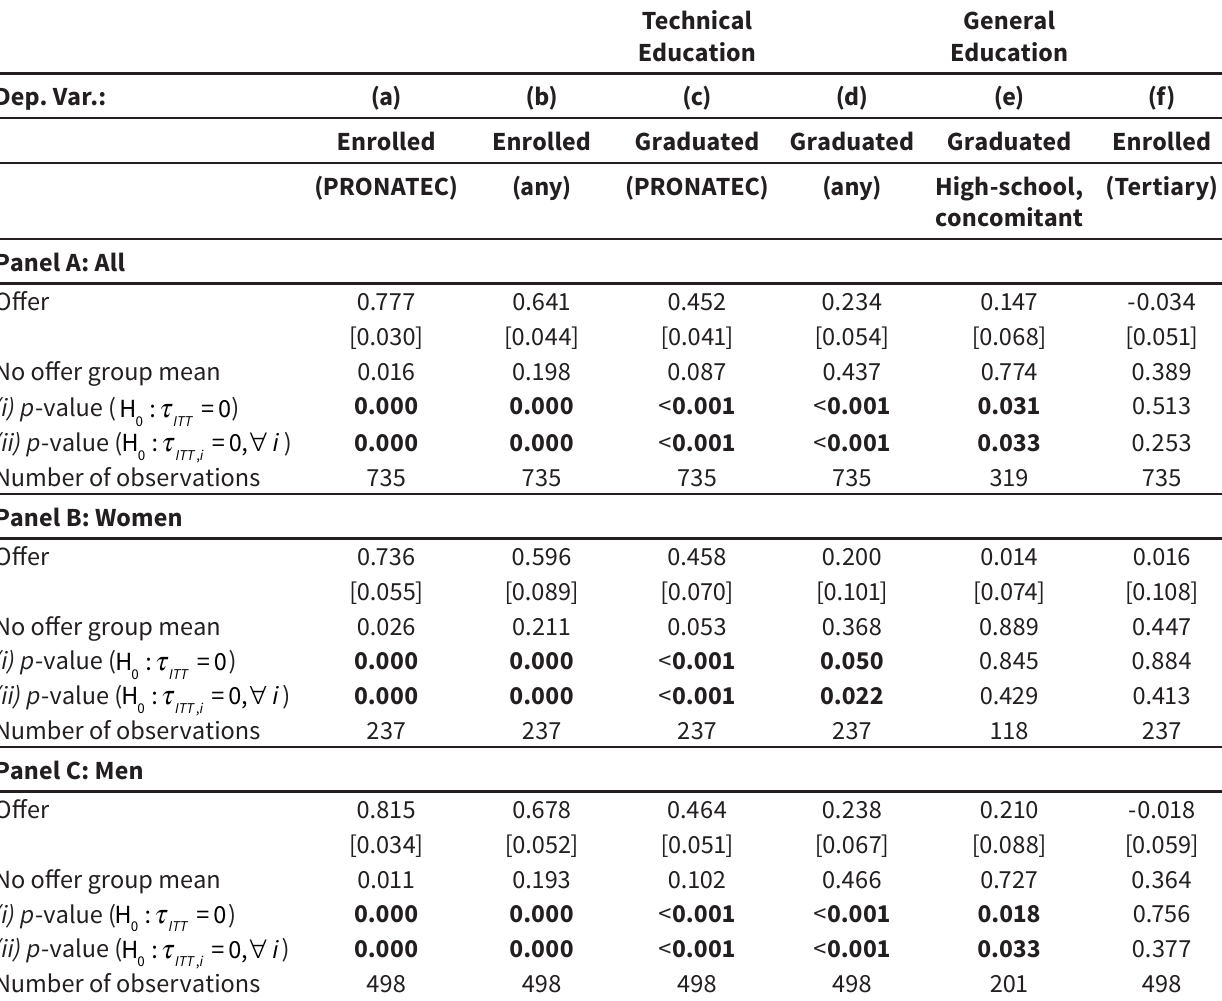
Table 4 Average Intent-to-treat Estimates on Technical and Non-Technical Education Graduation Rates